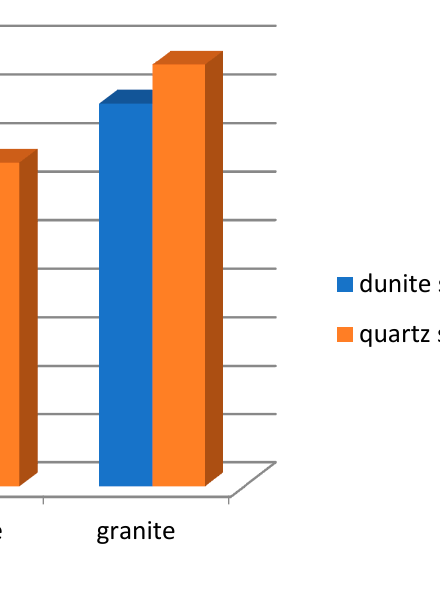
Figure 10. Dependence of water absorption of the concrete samples on the aggregate type.